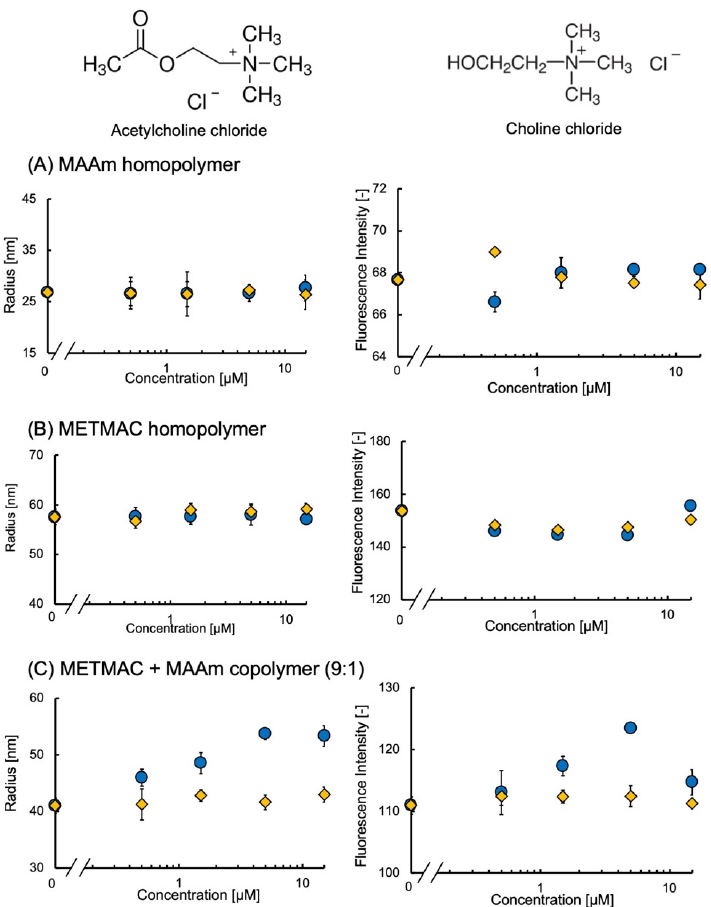
Figure 8. Effect of the acetylcholine (circles) and choline (diamonds) on the radius ( left ) and fluores- cent intensity ( right ) of the fNIP-NP synthesized with the ( A ) MAAM homopolymer, ( B ) METMAC homopolymer, and ( C ) copolymer of METMAC and MAAm. (Molar ratio of monomers prepared was 9:1.)